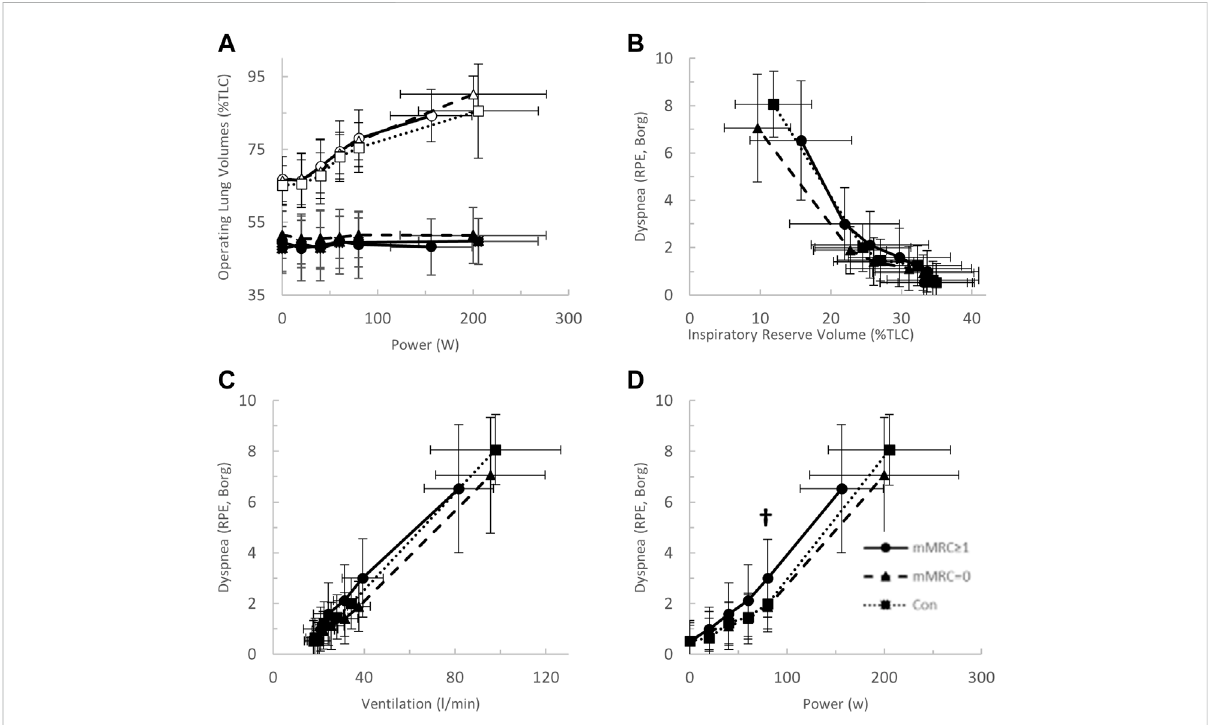
FIGURE 7 (A) The operating lung volume-power (open, end-inspiratory lung volume, closed, end-expiratory lung volume); (B) dyspnea-inspiratory reserve volume (as percent of total lung capacity, TLC); (C) dyspnea-power (Borg rating of perceived exertion, RPE); and (D) dyspnea-ventilation relationships in mMRC ≥ 1 (dyspneic-CoV, circles, solid line), mMRC = 0 (triangles, dashed line) and Con (squares, dotted line). † = p < 0.05 mMRC ≥ 1 vs